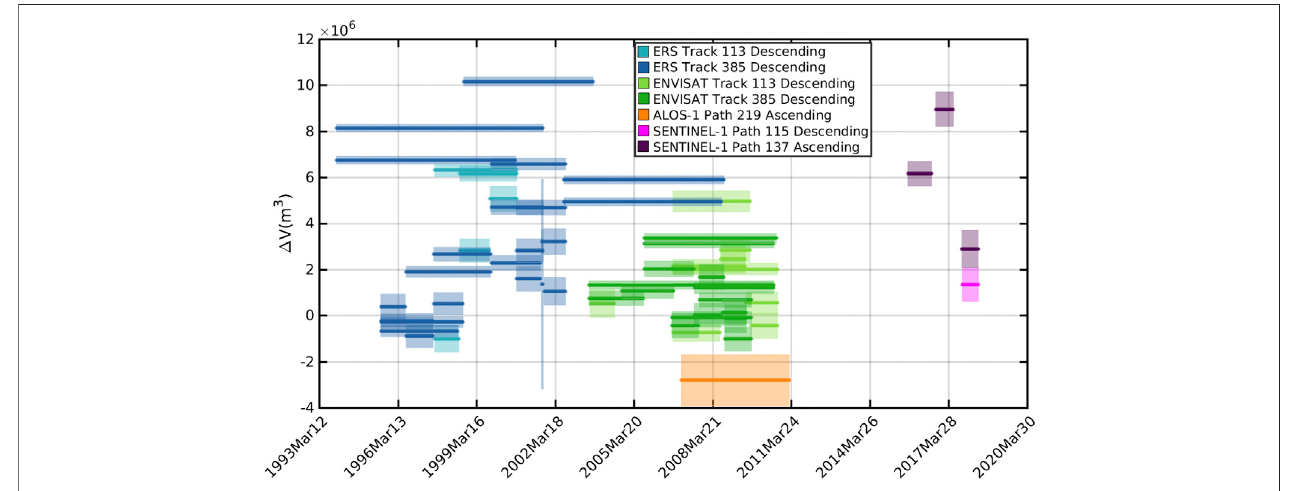
FIGURE 6 | Increments of volume change obtained for all interferograms (ERS, ENVISAT, ALOS-1 and SENTINEL-1), according with the median value for the source depth.